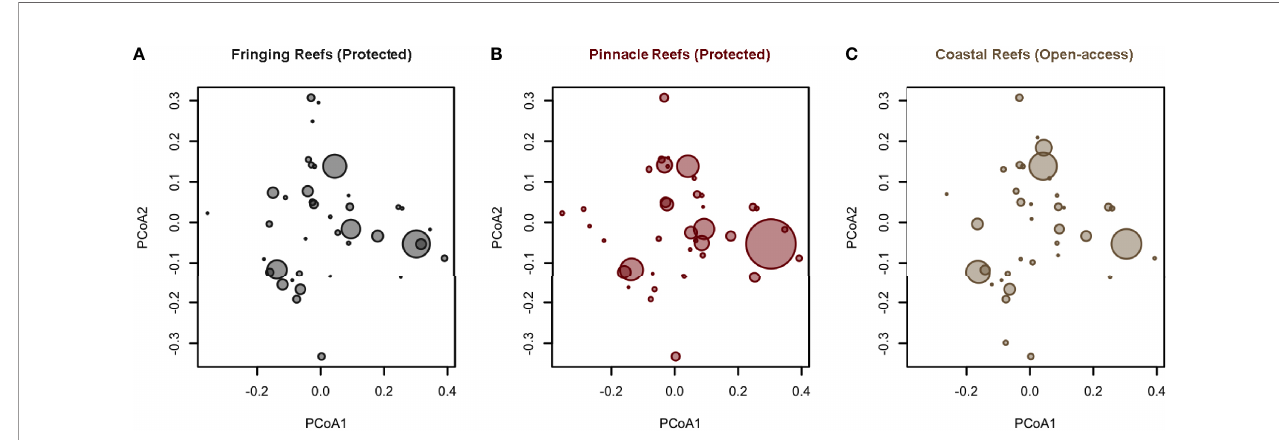
FIGURE 8 | Overall distribution of functional entities (unique trait combinations, FE) abundance across the functional space for areas with Fringing Reefs — Protected (A) , areas with Pinnacles Reefs — Protected (B) , and areas open to fi sheries (C) . Each point represents an FE, and the size of the circles is proportional to the relative cover of the species belonging to a certain functional entity. Number of species = 86; number of FEs =